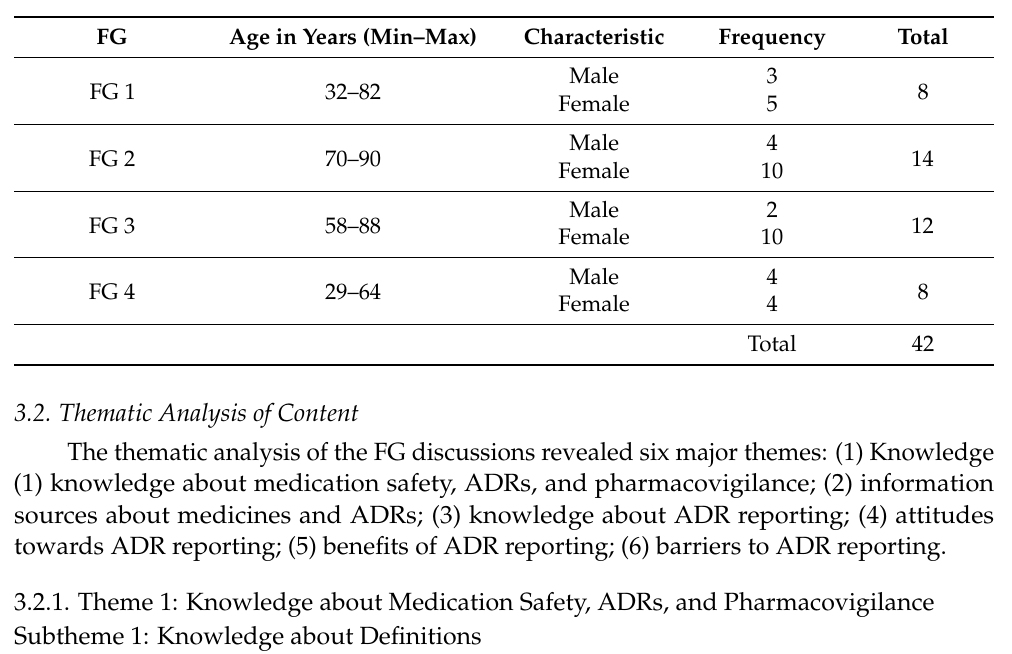
Table 1. Characteristics of participants in focus groups